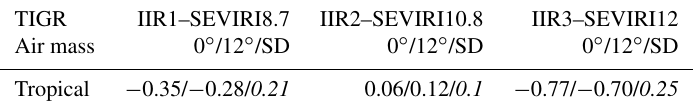
Table 4. Simulated brightness temperature difference (TIGR_BTD) in Kelvin between IIR and SEVIRI/Meteosat 8 companion channels for SEVIRI viewing angles of 0 and 12 ◦ , and standard deviation (in italic) for the tropical air mass type from the TIGR data